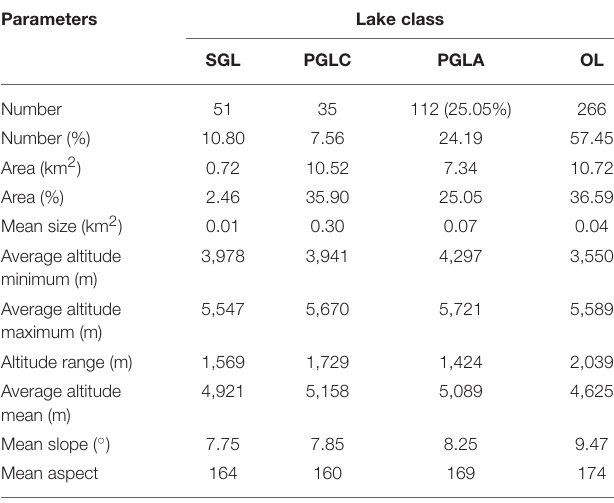
TABLE 2 | Lake characteristics for 2000 in the Sikkim.